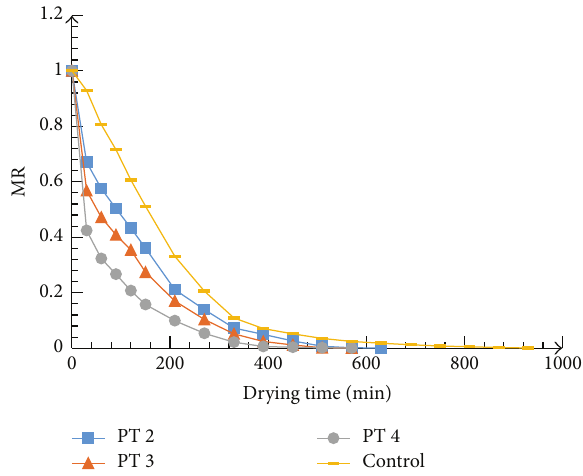
Figure 3: Variation of MR versus drying time at microwave power 600